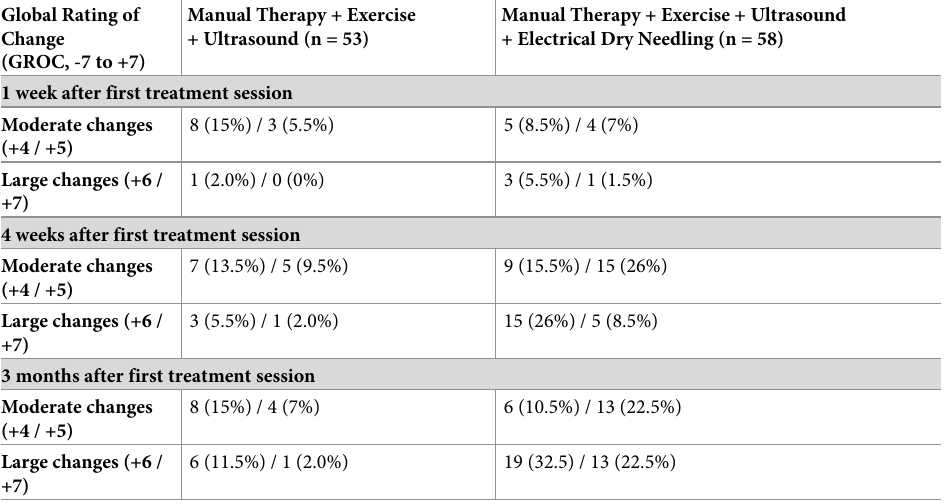
Table 4. Self-perceived improvement with Global Rating of Change (GROC) in both groups [n